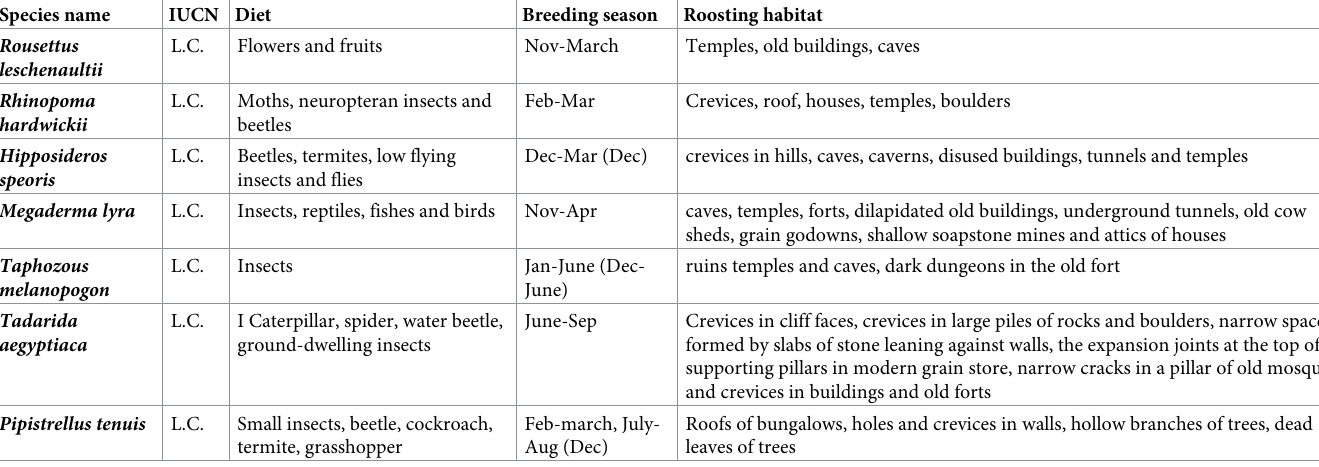
Table 1. Species characteristics and IUCN status of bats recorded in temples. The breeding season in parenthesis is based on the present study.